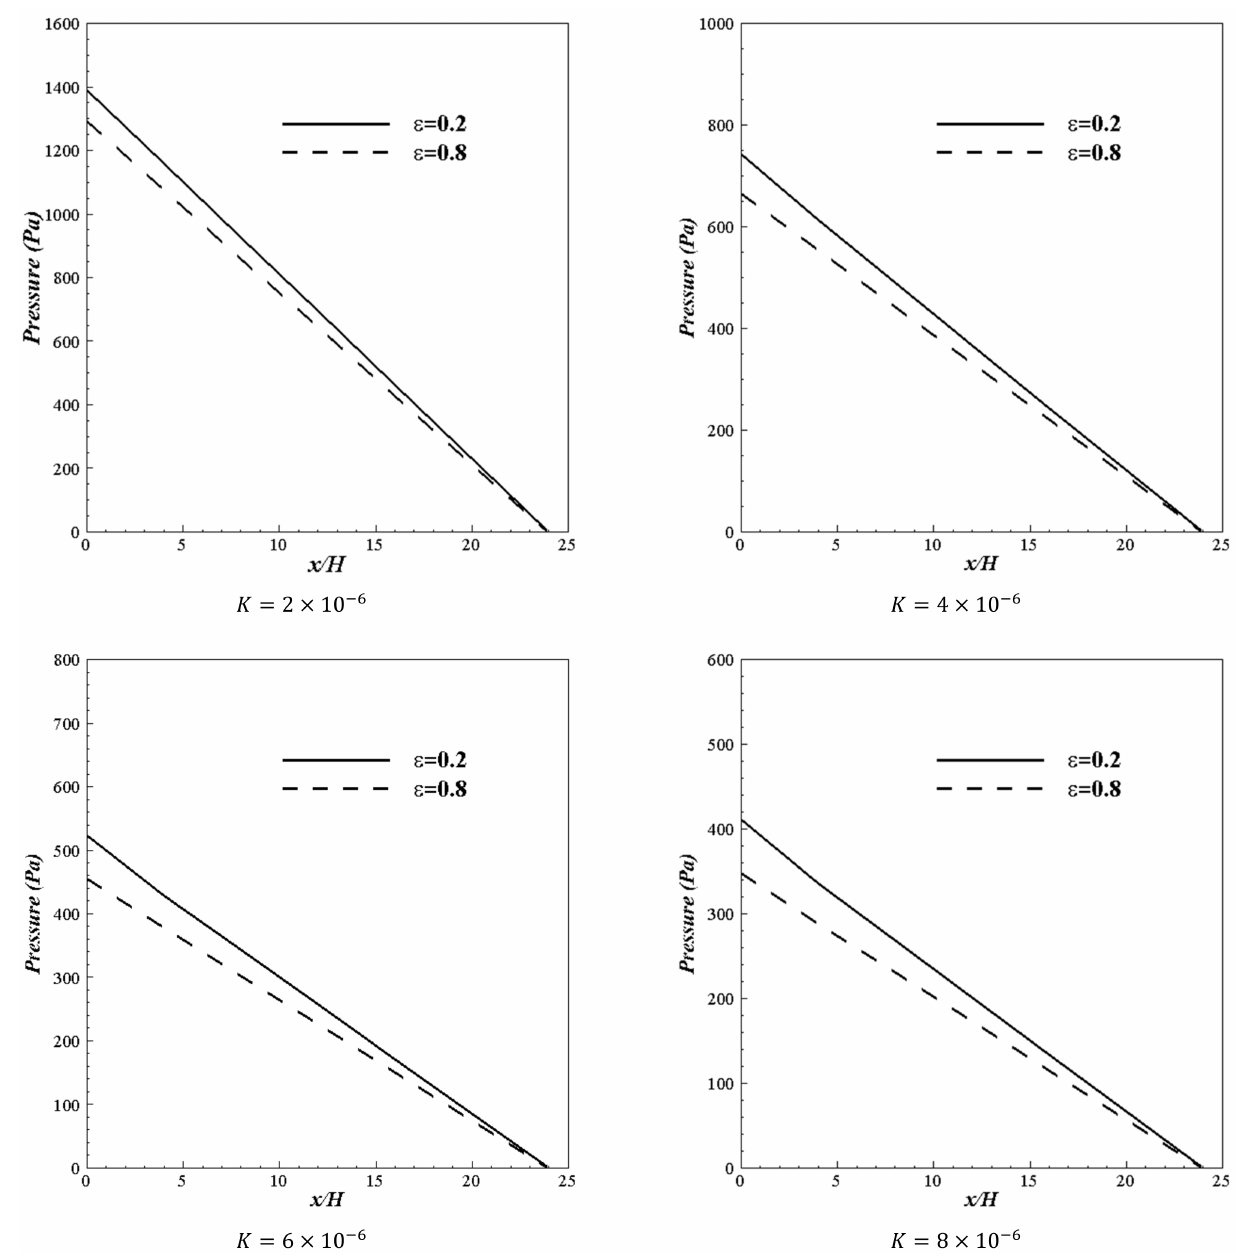
Figure 10. The variation in pressure across the collector versus the length to height ratio for the different values of permeability at the high, 0.8, and low, 0.2, porosity coefficients, with u in = 2 m/s. The time-dependent variations in concentration can present a complete approach to flow movement into the solar collector. The variations were calculated by considering the developed Brinkman model for the momentum and energy equations. Figure 11 shows the concentration contours in the porous collector for three different times and for a low porosity coefficient of 0.2. The distribution was affected by the temperature gradient made by the solar heat flux, considering the coupling of mass, momentum, and